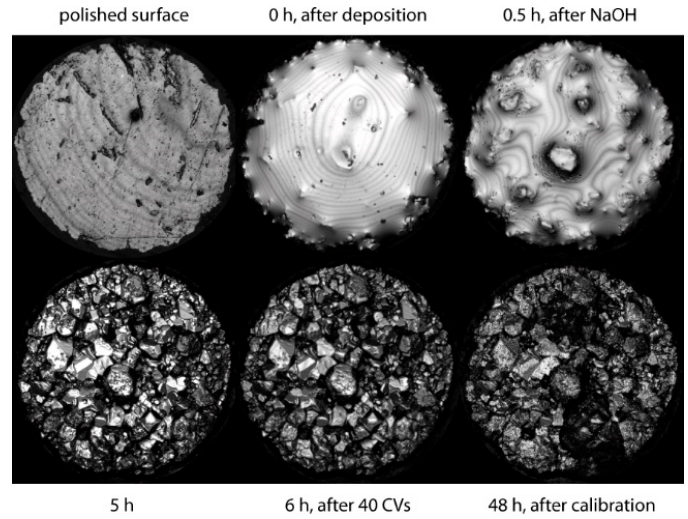
Figure 11. Change of gold amalgam electrode surface over time (100-µm diameter).